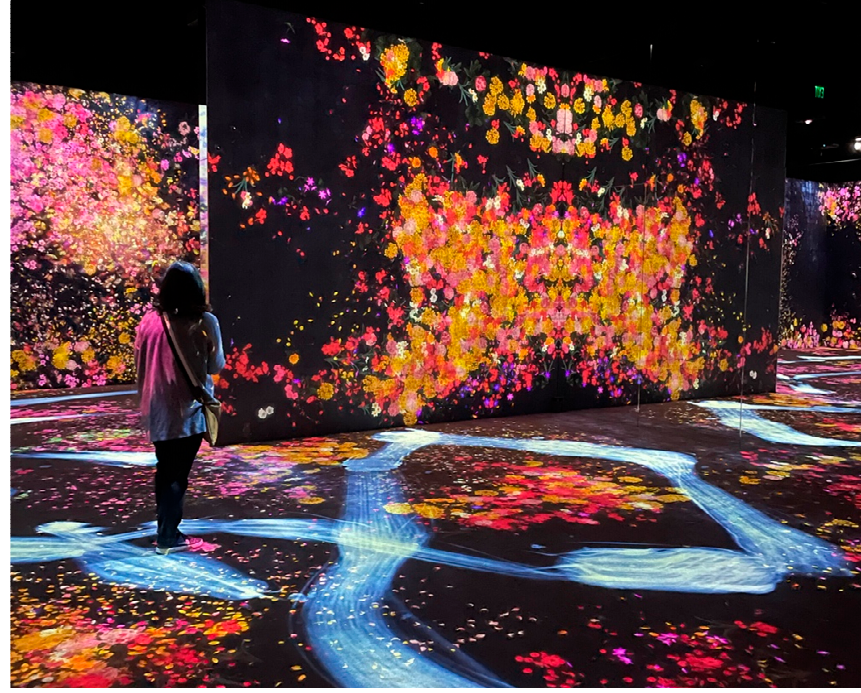
Figure 8. teamLab, Forest of Flowers and People: Lost, Immersed and Reborn (Spring), 2017/2021, Asian Art Museum of San Francisco; photograph by the author, 2022